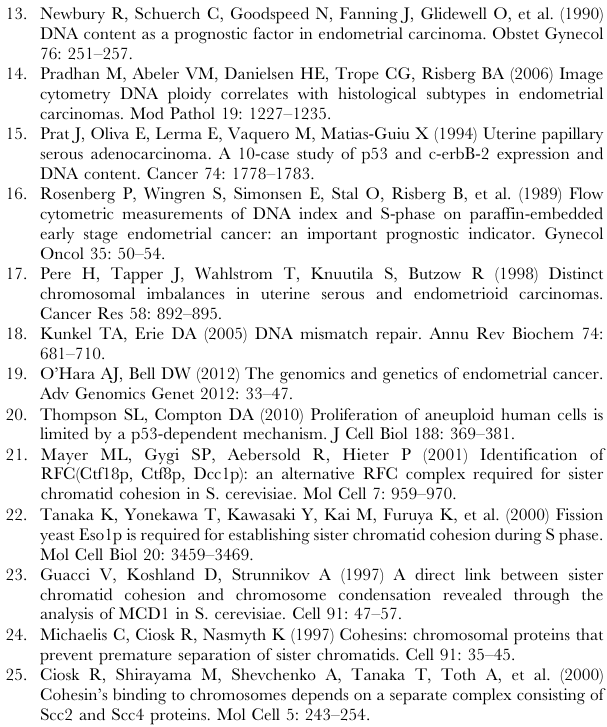
Figure S5 Oncoprints displaying the distribution of somatic mutations in endometrioid endometrial tumors as reported in this study (*) and elsewhere [ 44 ] , [ 52 ] , [ 53 ] , [ 54 ] . Each blue bar represents an individual tumor (T). Nonsynonymous somatic mutations and MSI + are indicated by the red bars. For MSH6 , germline variants of unknown functional significance are displayed by orange bars. The observed frequency (%) of mutated cases, for each gene, is shown on the right. Figure S6 Immunoblots showing expression levels of the MRE11A, CHTF18 and ESCO1 proteins among a panel of 7 human endometrial cancer cell lines. Tubulin was used as a control for protein loading. Figure S7 Oncoprint displaying patterns of somatic mutations in ESCO1 , CHTF18 , MRE11A , and ATAD5 in colorectal cancer, as reported by The Cancer Genome Atlas (TCGA). (Upper panel) Individual colorectal tumors are indicated by vertical gray bars. Genes (left) and nonsynonymous somatic mutations (orange bars) are indicated. (Lower panel) In colorectal cancers, mutations in ATAD5 and ESCO1 showed a strong tendency towards co-occurrence; mutations in MRE11A and ESCO1 , and in ATAD5 and MRE11A showed a tendency towards co-occurrence. The data were derived from 224 sequenced samples; the TCGA data were accessed, and the mutual exclusivity calculated via the cBio Cancer Genomics Portal (http://www.cbioportal.org/public-portal/).